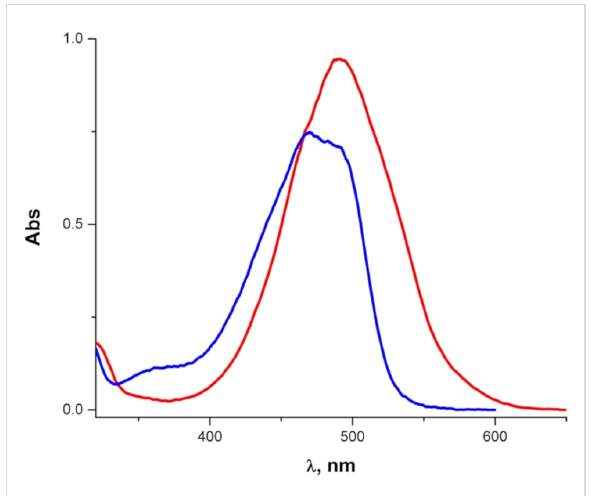
Figure 7: Absorption spectra of 7a (blue) and 8 (red) in ethanol.